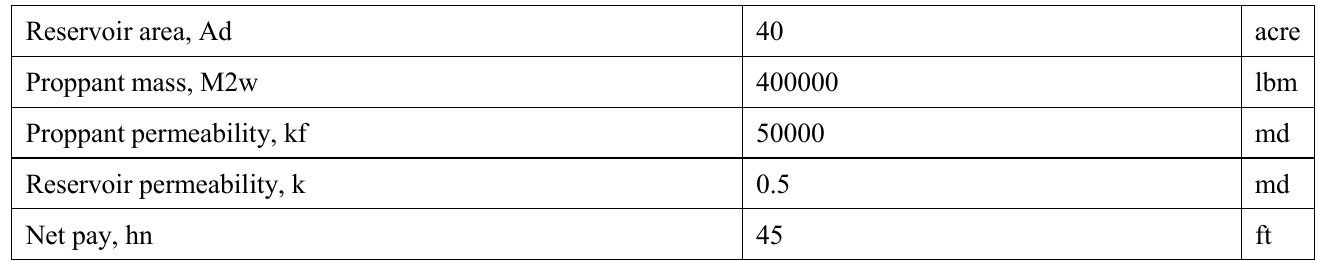
Table 4—Reservoir